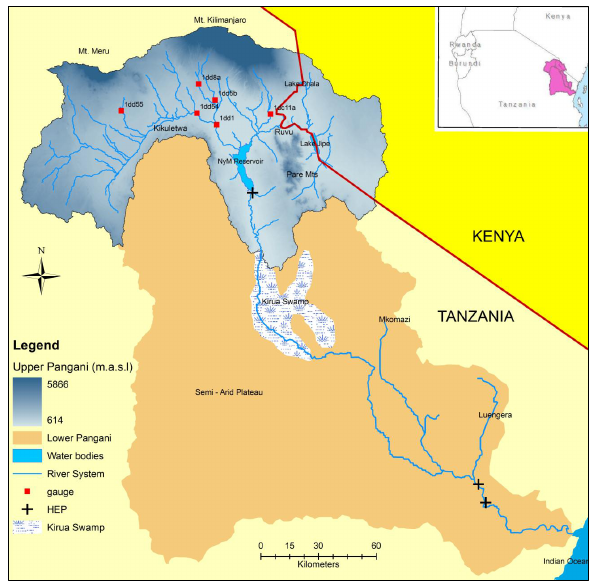
Figure 1. Overview of entire Pangani River basin and the upper Pangani River